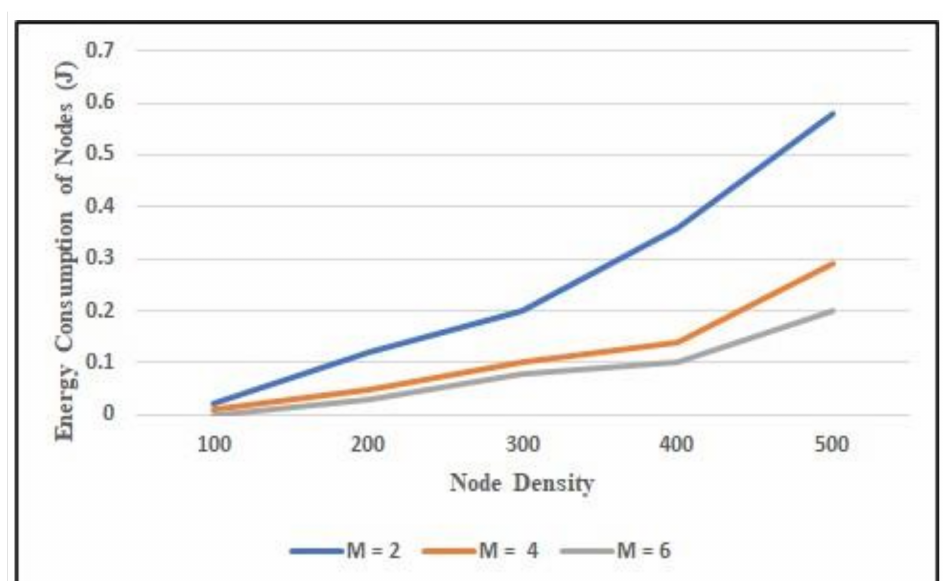
Figure 15. Effect of number of MCs on the total energy consumption of